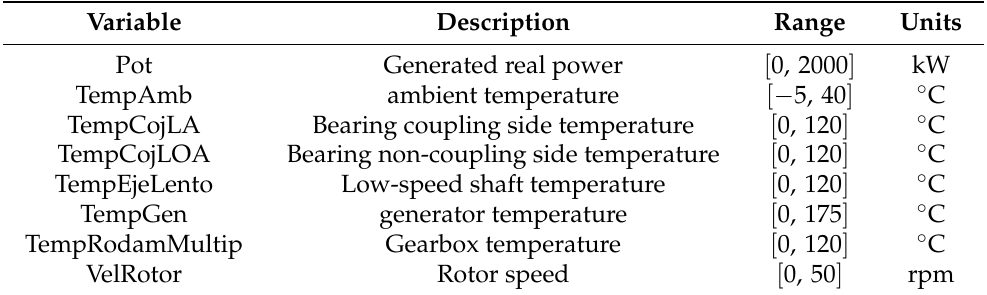
Figure 9. Plot example of the selected supervisory control and data acquisition (SCADA) variables used to develop the normality model. All of them are related to the mean value over a 10-min period. Table 7. Selected SCADA variables used to develop the normality model, its description, range of possible values, and units. All of them are related to the mean value over a 10-min